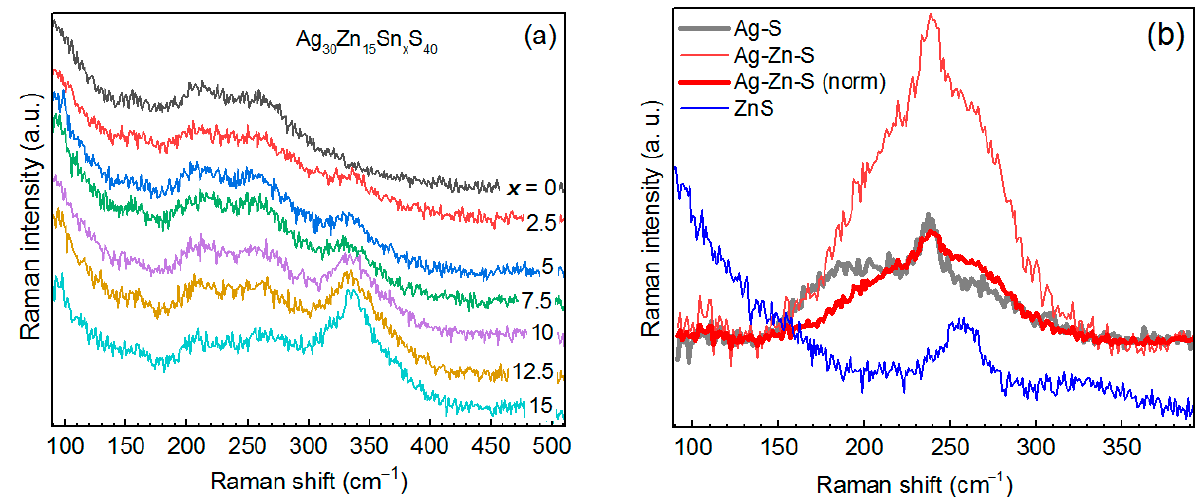
Figure 6. ( a ) Raman spectra of the series of Ag 2 ZnSn x S 4 NCs at λ exc = 514.7 nm. ( b ) Raman spectra of the Ag-Zn-S and Ag-S NCs at λ exc = 638 nm; the Ag-Zn-S NC spectrum is also presented (thick red curve) normalized to that of the Ag-S, in order to underline the different lineshapes for two compounds. The spectrum of ZnS NCs is shown for comparison.